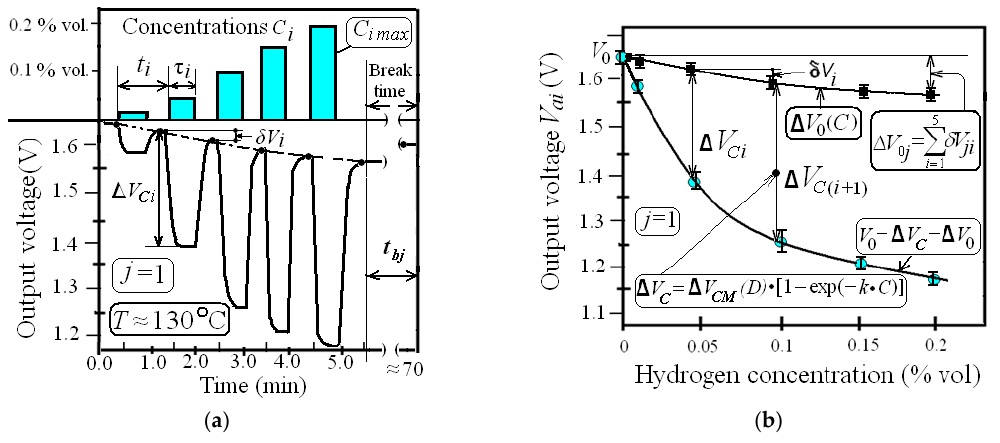
Figure 4. The response parameters: ( a ) Time diagram of the typical j -ordinary cycle at di ff erent C i ; ( b ) Experimental (symbols) and approximations (lines) of the response residual sum values ∆ V 0 and amplitudes ∆ V C vs. concentration C for the first j -cycle. Table 2. Designations and n lkji -response parameters ( Y lkji ) for the characterization of instabilities and